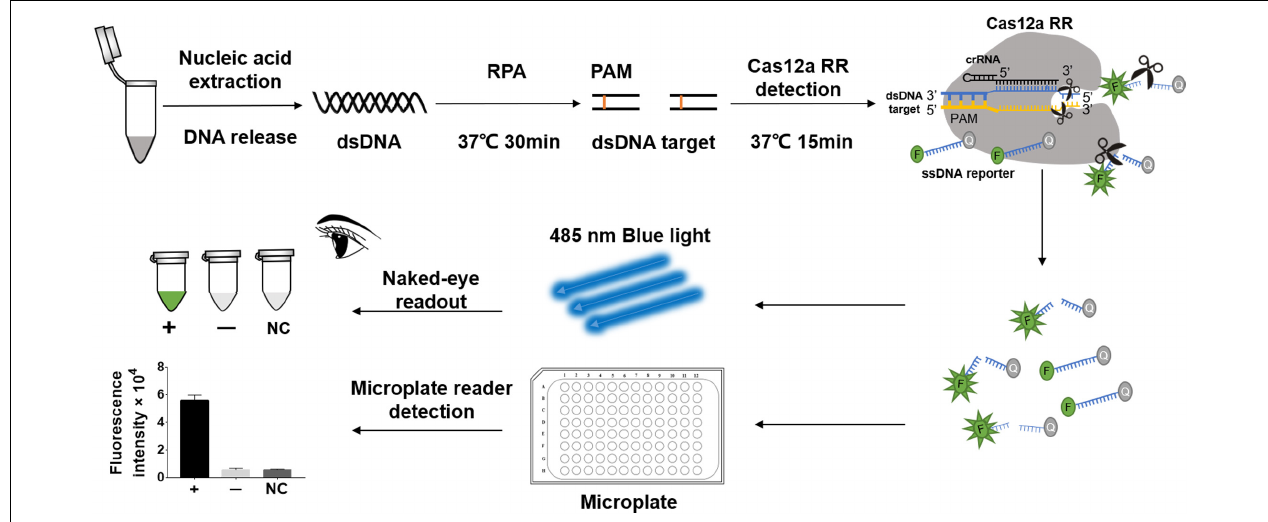
FIGURE 1 | Schematic diagram of CRISPR/Cas12a RR in detecting streptomycin (STR)-resistant Mycobacterium tuberculosis . Schematic diagram of Cas12a RR-mediated STR-resistant M.tb genome detection. Specific CRISPR-guided RNAs (crRNAs) targeting the M.tb rpsl gene were designed for STR-resistant M.tb detection. When CRISPR/Cas12a RR proteins cleave double-stranded DNA with the specific crRNA guide, they induce robust and non-specific single-stranded DNA (ssDNA) trans -cleavage. The ssDNA (sequence TTATT) reporter fluoresces when the quenched fluorescent ssDNA is cleaved (Chen et al., 2018; Xiao et al., 2020). F, fluorophore; Q, quencher.